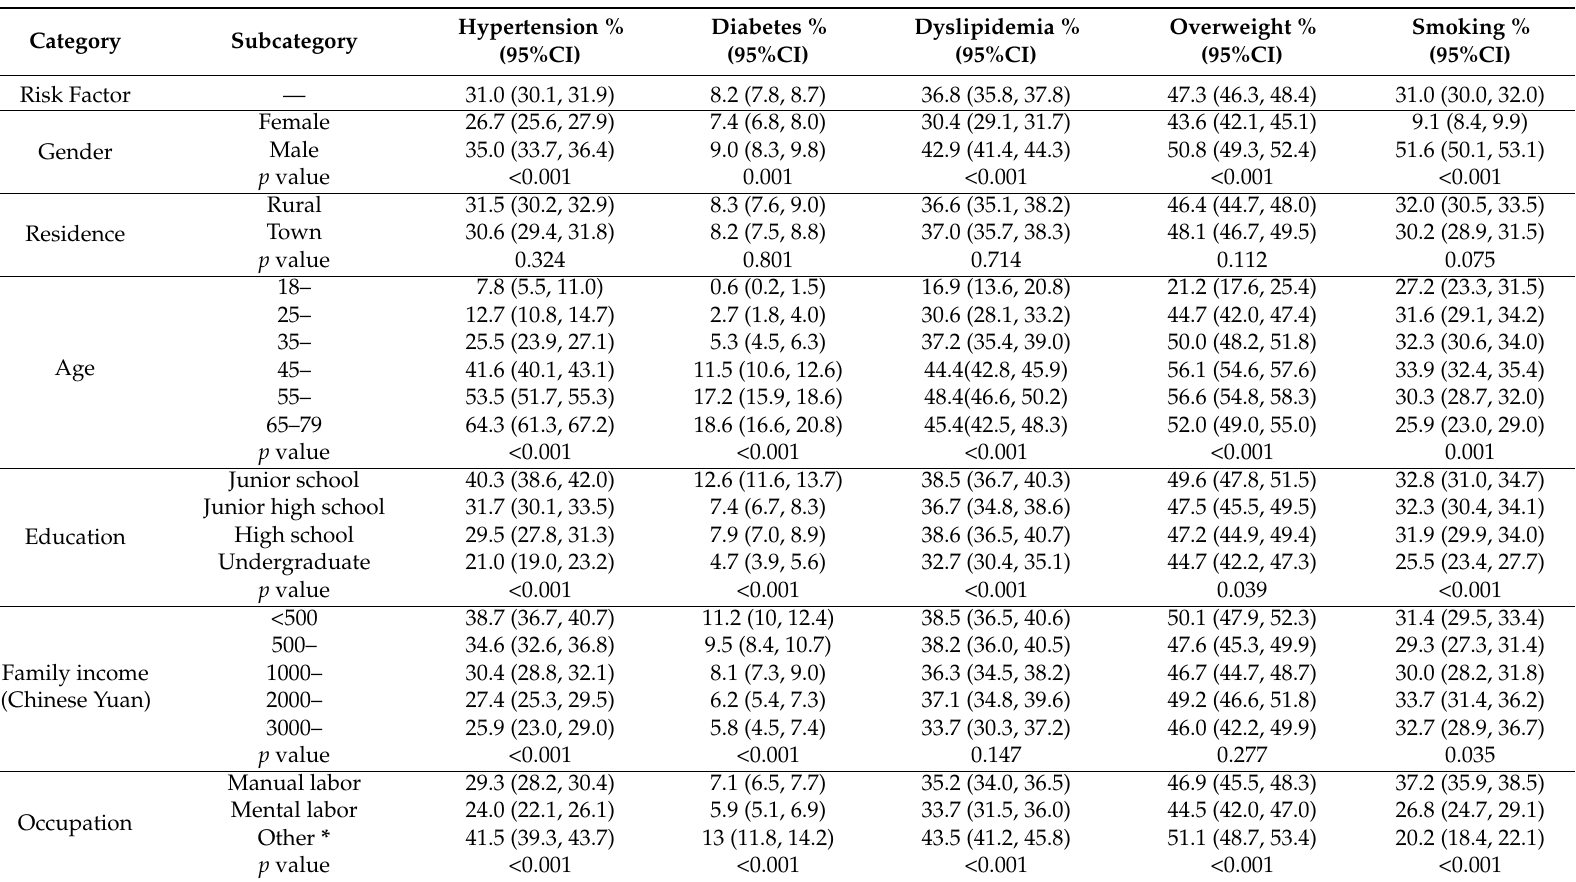
Table 2. Prevalences of CVD risk factors by demographic